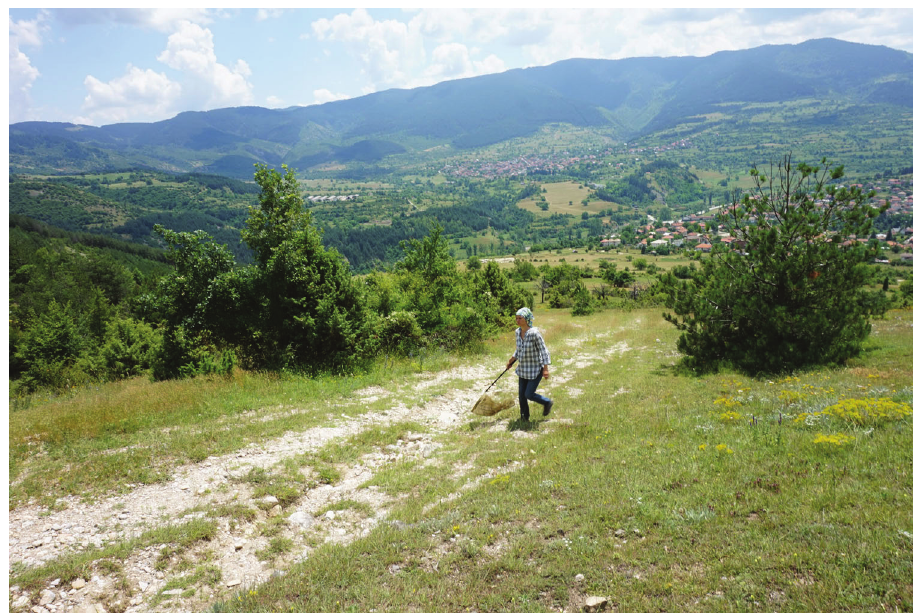
Figure 38. Habitat of P. orphicus orphicus. Bulgaria, Hvoyna, 3 July 2016. Photo by I. Zubkova.